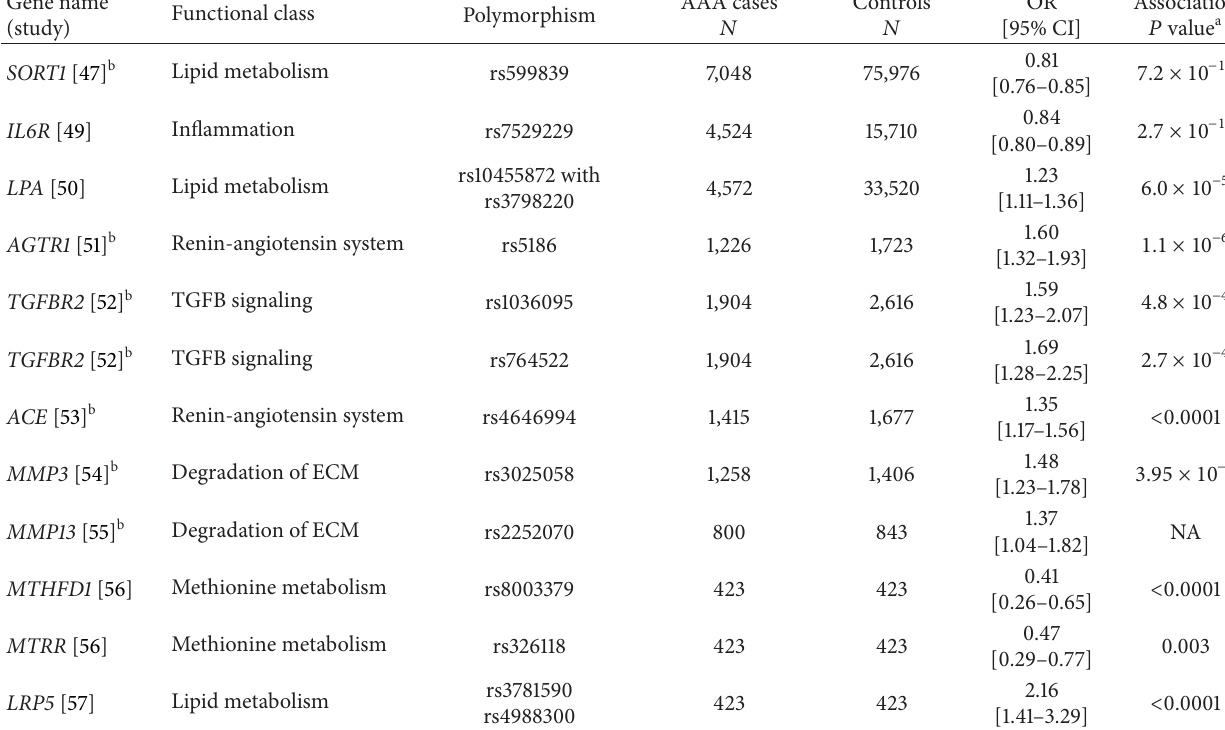
Table 3: Most significant associations with AAA discovered in candidate gene and pathway-based